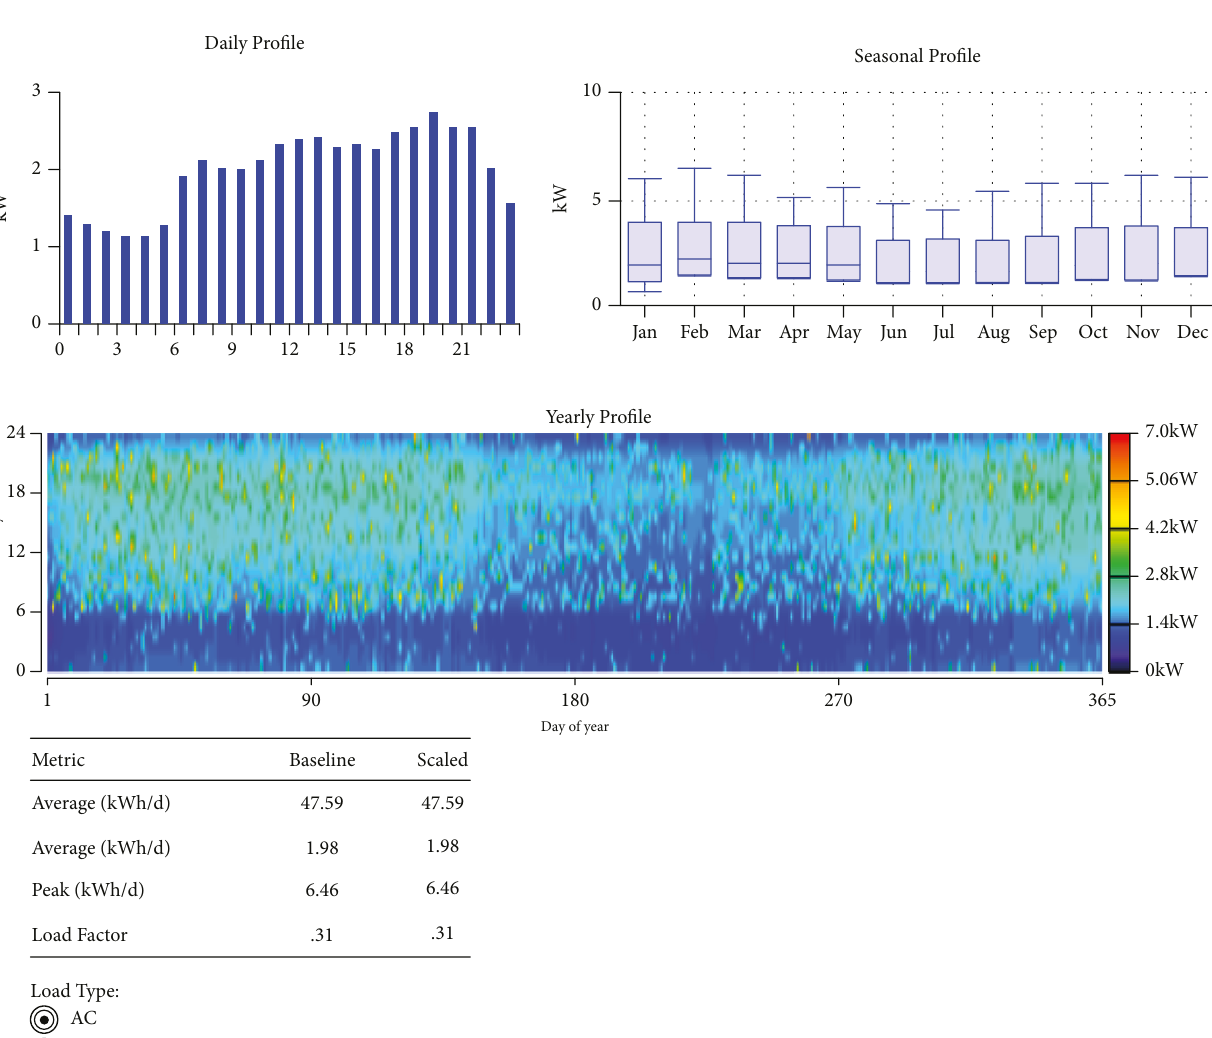
Figure 4: Daily, monthly, and annual load pro fi le of the house from BEopt